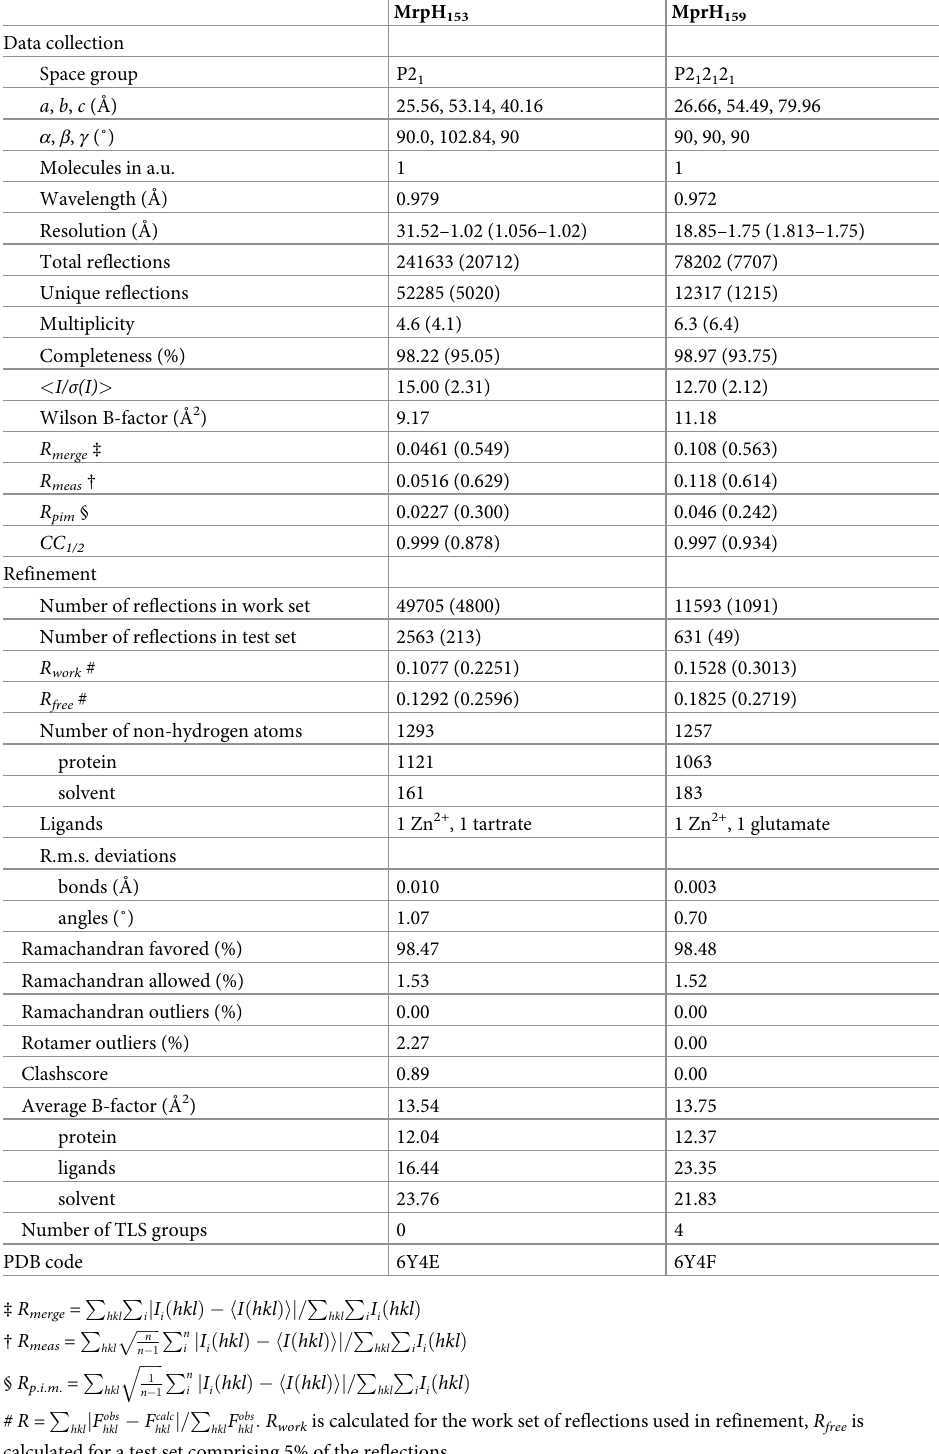
Table 1. Native data collection and refinement